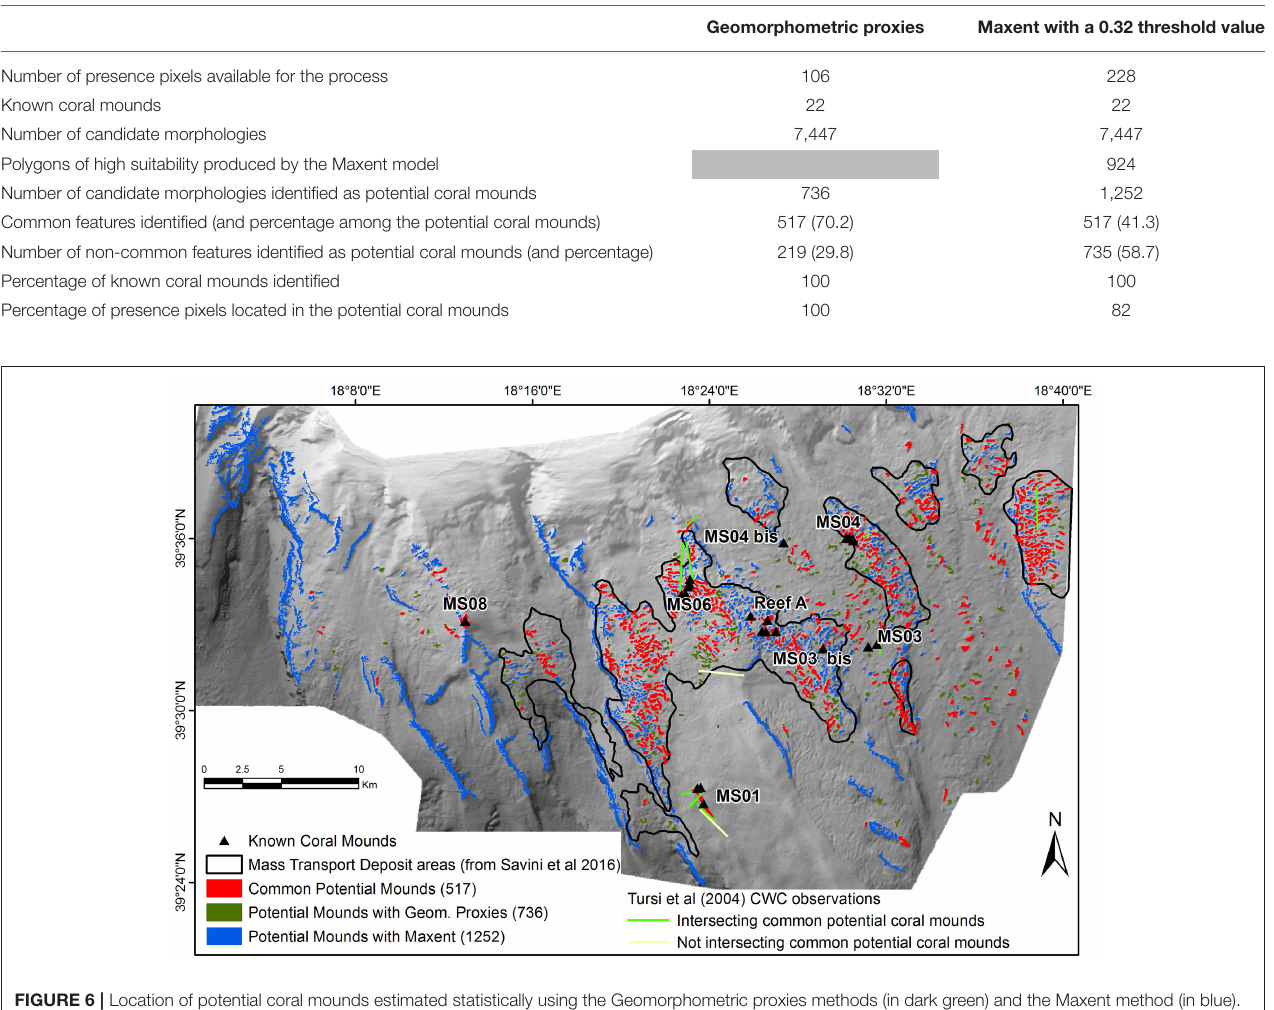
FIGURE 6 | Location of potential coral mounds estimated statistically using the Geomorphometric proxies methods (in dark green) and the Maxent method (in blue). The 517 common potential coral mounds (in red) represent 70.2% of the Geomorphometric proxies and 41.3% of the Maxent features. Mass Transport Deposit areas described by Savini et al. (2016) are delineated by black lines and hauls from Tursi et al. (2004) holding CWC are shown by yellow and green